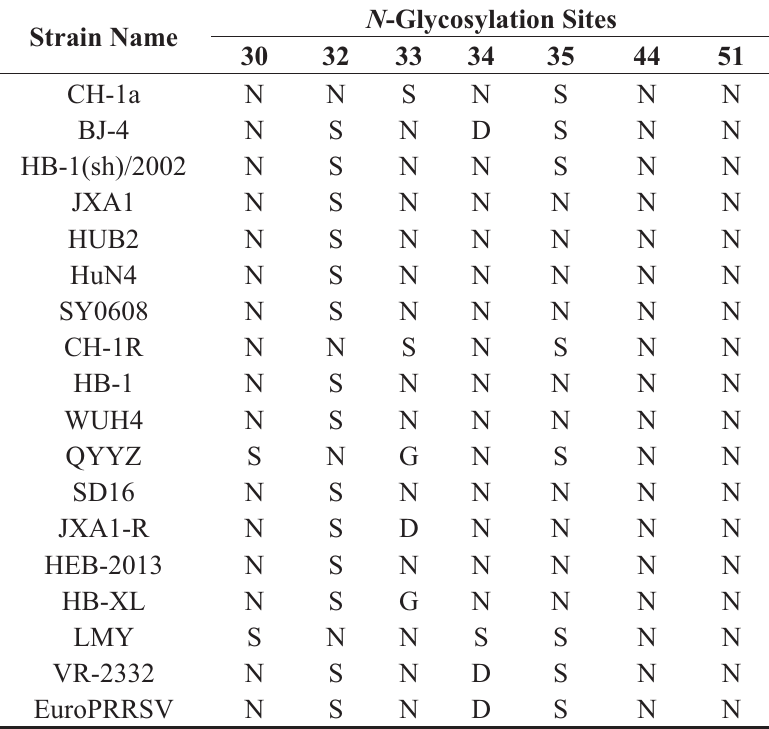
Table 4. N -glycosylation sites in PRRSV